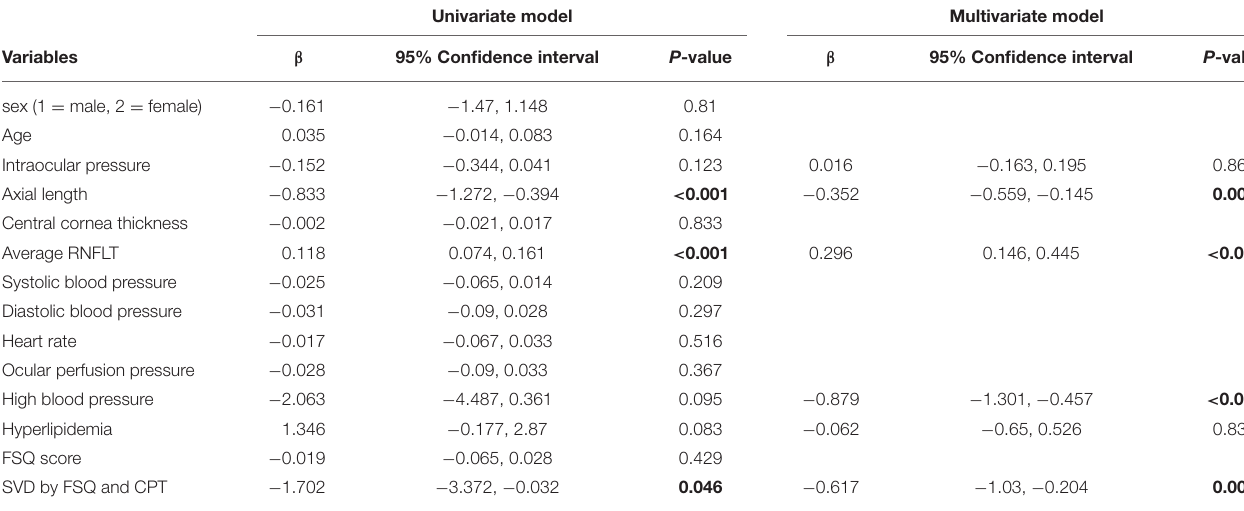
TABLE 3 | Univariate and multivariate generalized estimation equation analyses for factors associated with average RPC vessel